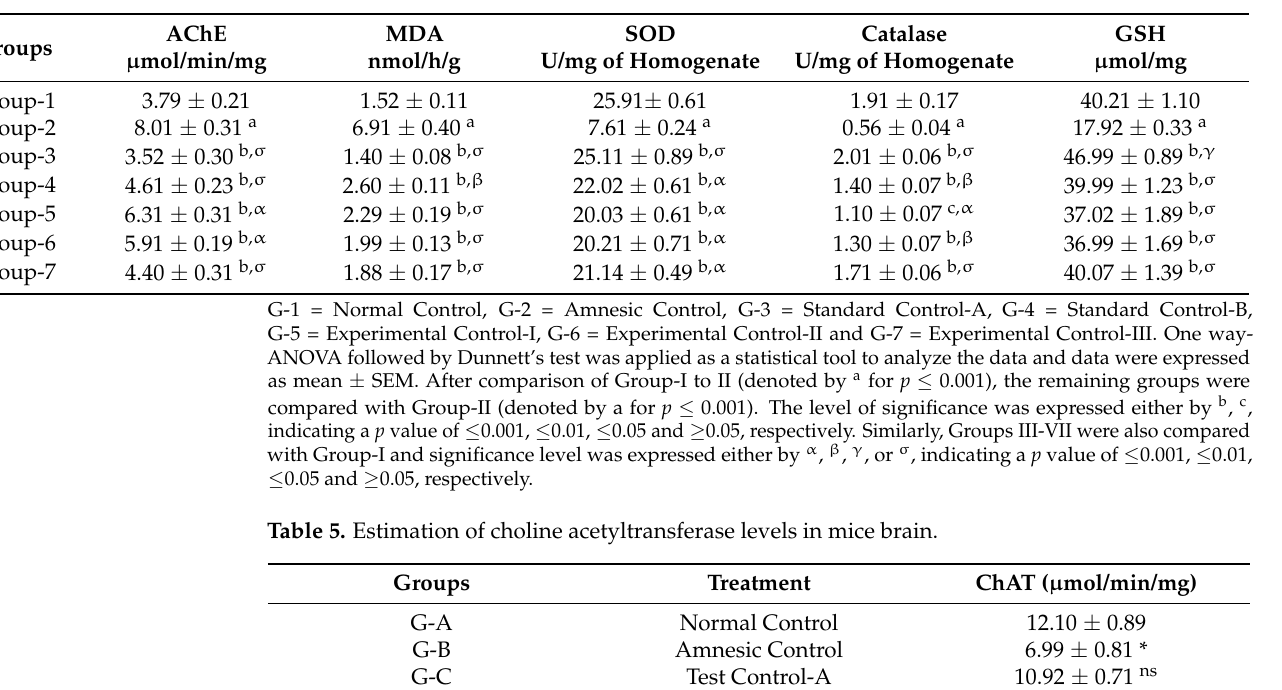
Table 4. Estimation of levels of AChE, MDA, SOD, CAT and GSH in mice brain.